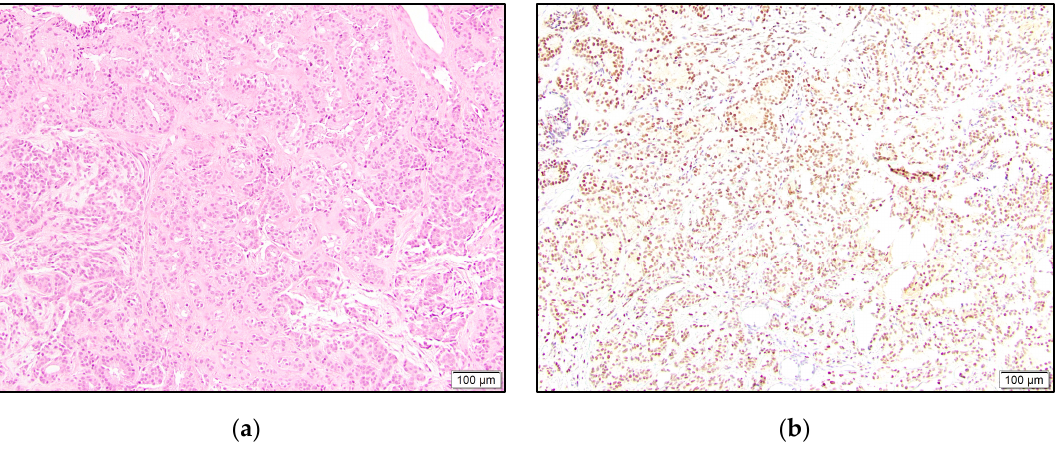
Figure 1. Eccrine adenocarcinoma with glandular architecture ( a ) and high positive TRPS1 expression ( b ).